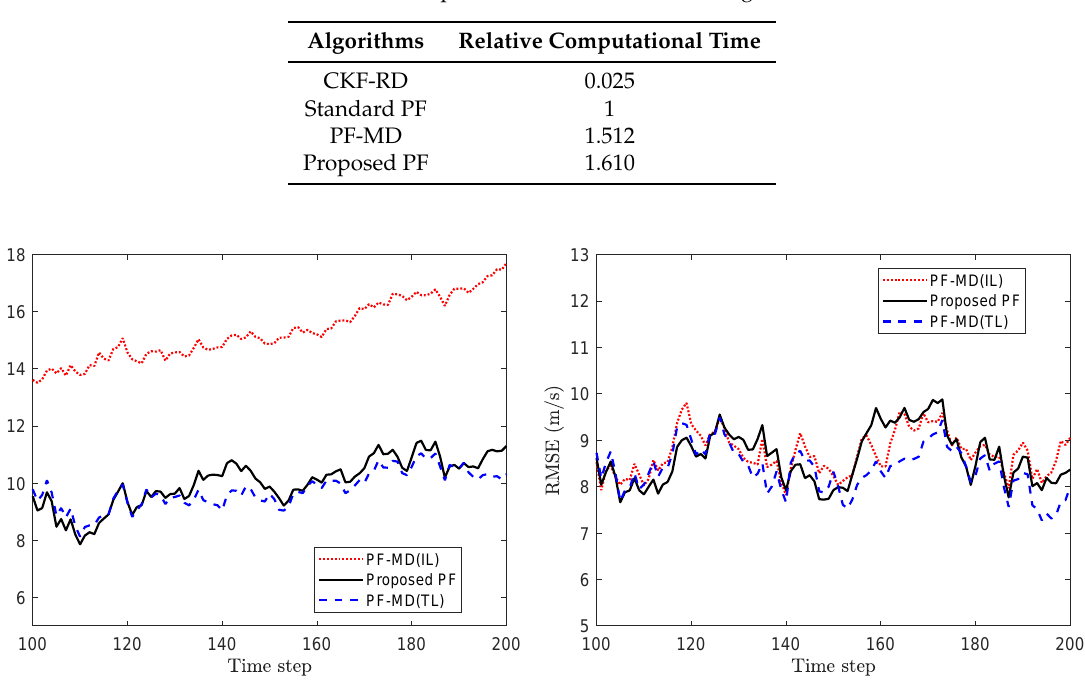
Table 5. Relative computational time for different algorithms.